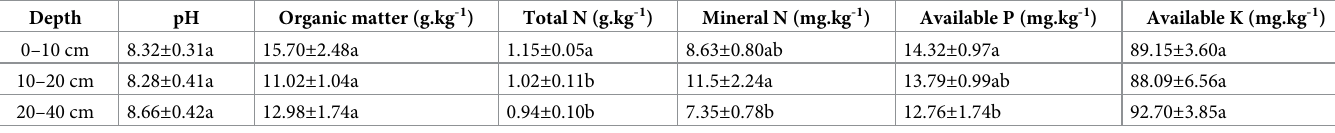
Values with different letters in the same column indicate significant differences between treatments ( p < 0.05, n = 3). Data are means ± standard